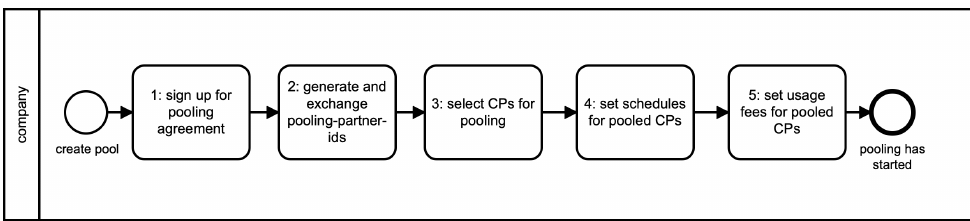
Figure 2. Main steps to initiate a pool of charging